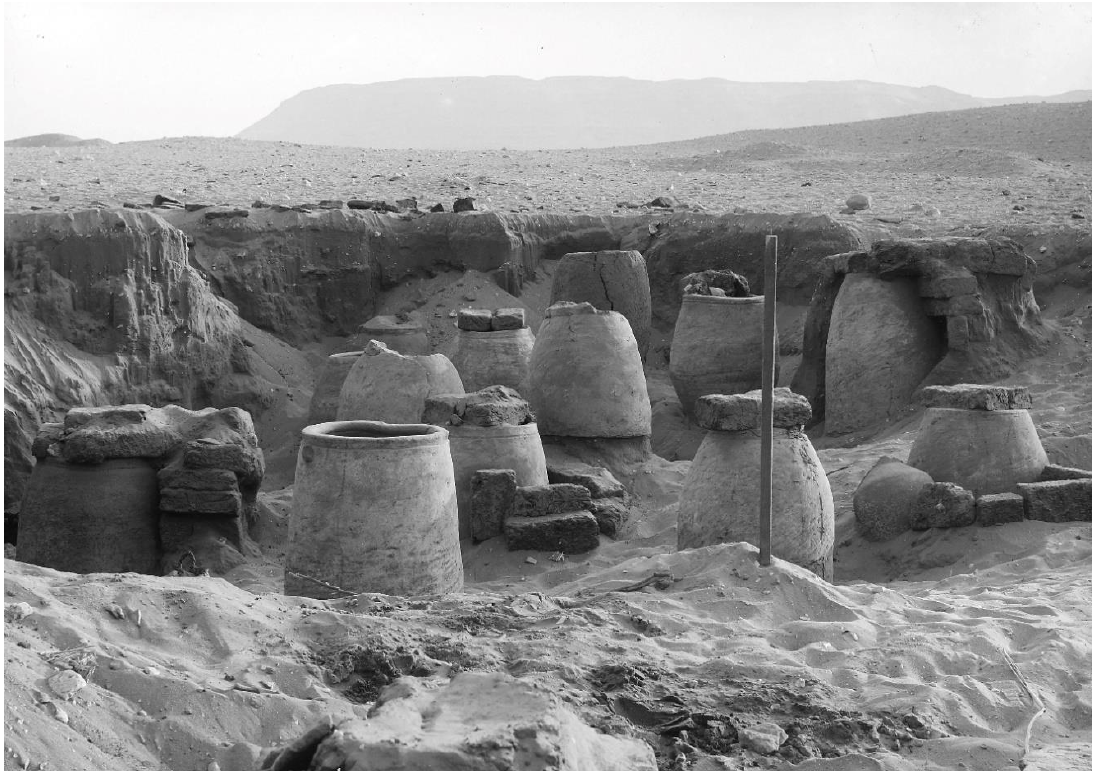
Figure 3. Excavation photograph showing a number of large ceramic vessels which were found to contain ibis mummies. [Reproduced by kind permission of the Egypt Exploration Society, London.].